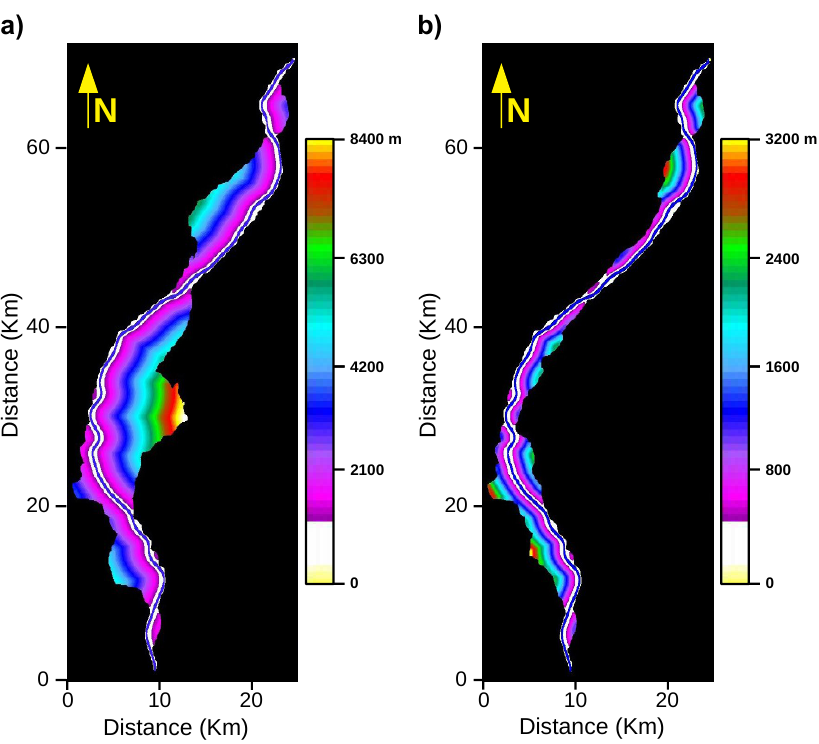
Figure 5. VP-CMP distance maps (meters) for Metal Earth Swayze line. ( a ) Unlimited offset. ( b ) Limited offset to 15